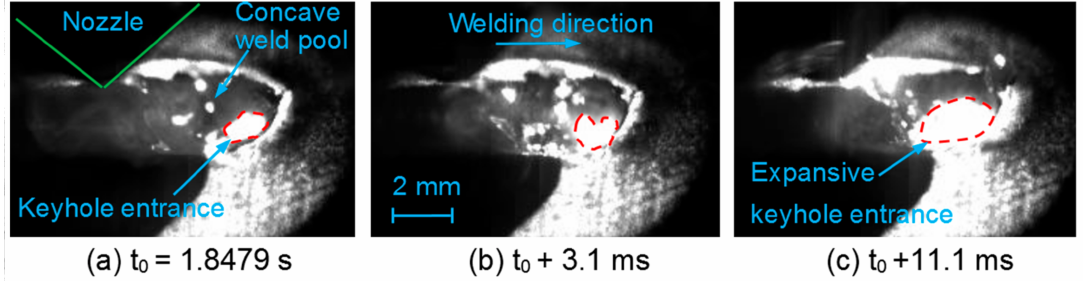
Figure 6. Images of the keyhole entrance and surface weld pool dynamics with a rear gas jet (p = 10 kW, v = 0.9 m/min, ∆ = − 5 mm, q = 10